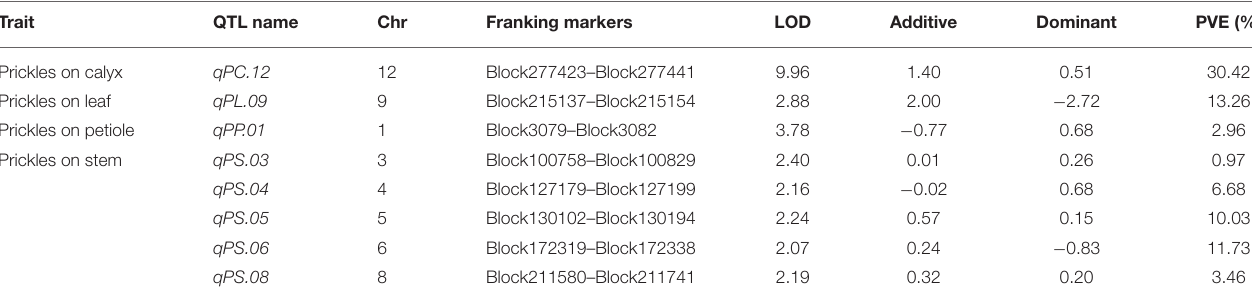
TABLE 1 | Quantitative trait loci (QTLs) for the prickle numbers on calyx, stem, leaf, and petiole.